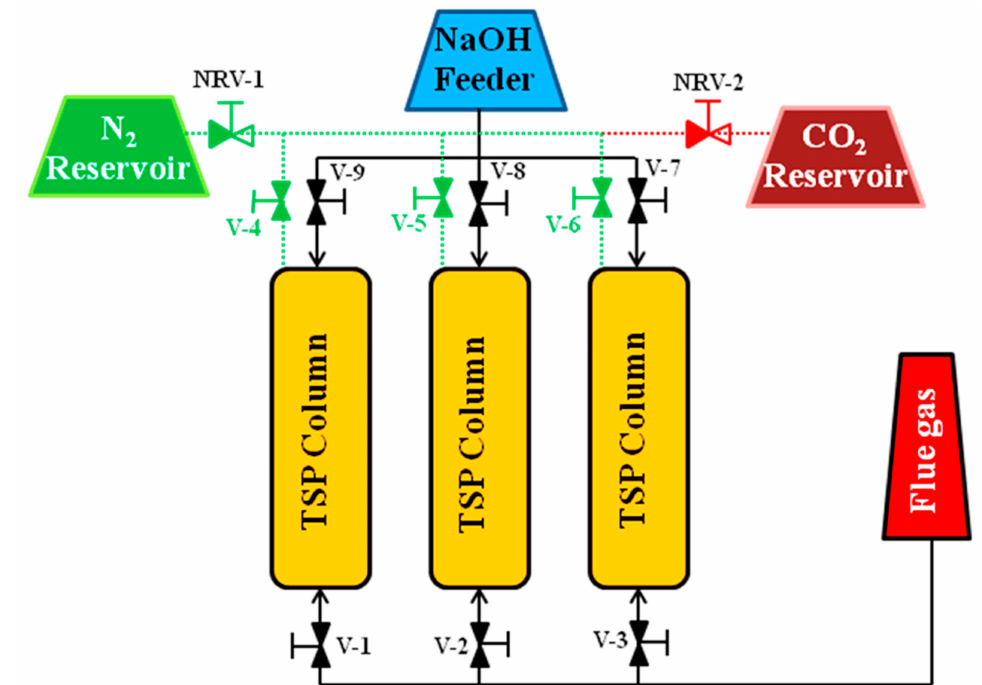
Figure 10. A conceptual prototype for TSP-based post-combustion CO 2 capture at ambient